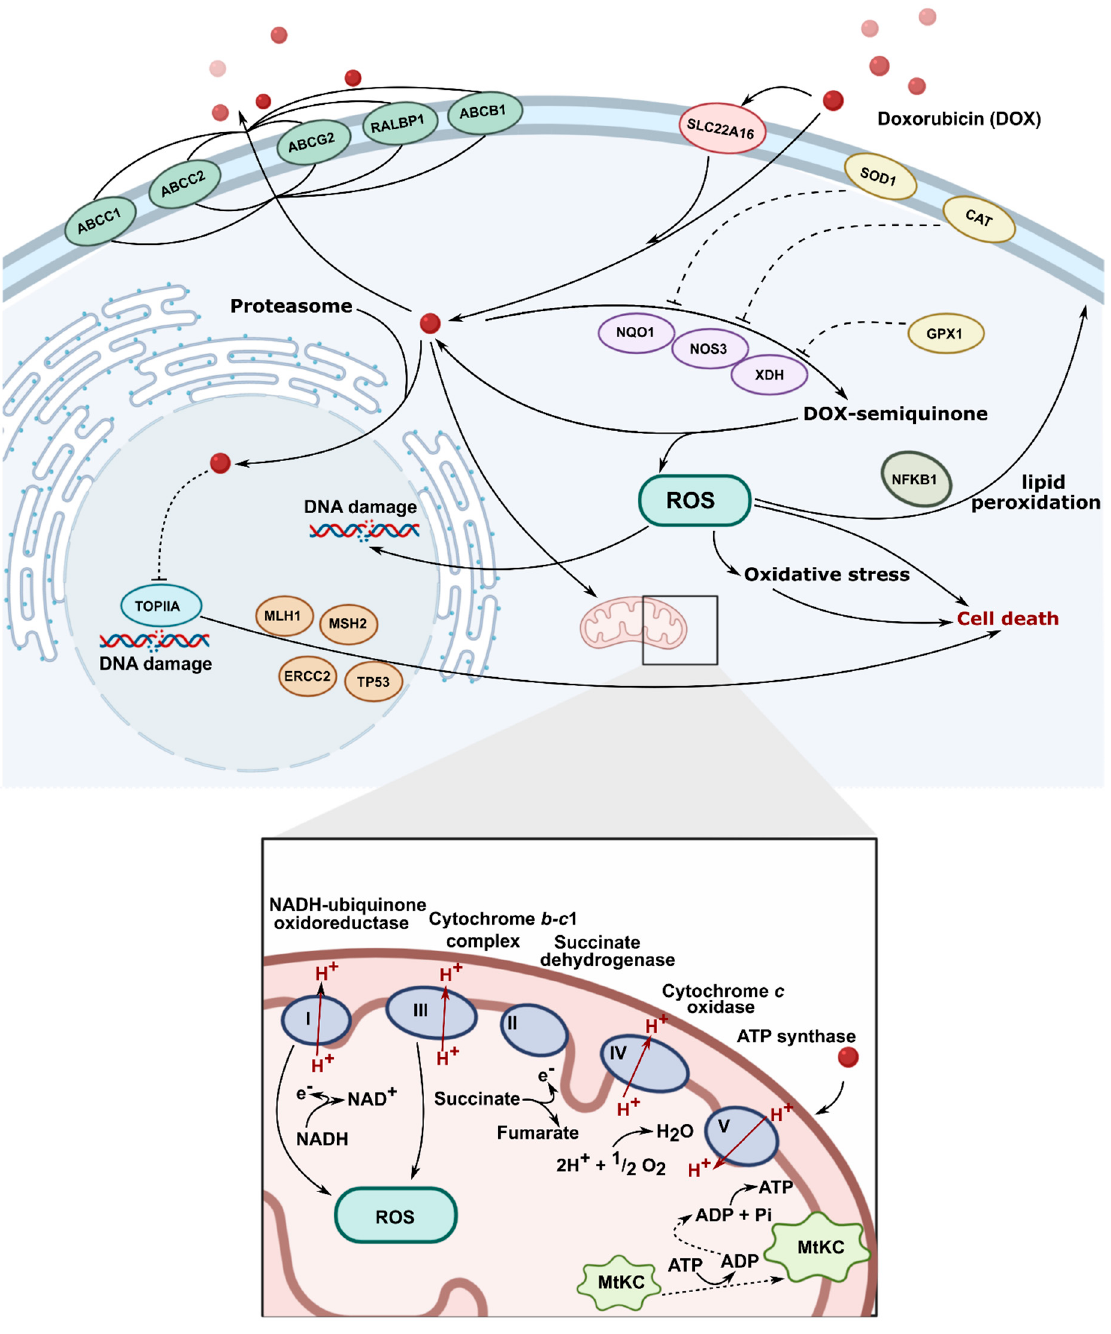
Figure 2. Molecular mechanism of action of doxorubicin (TOPIIA-topoisomerase II, ROS-reactive oxygen species).